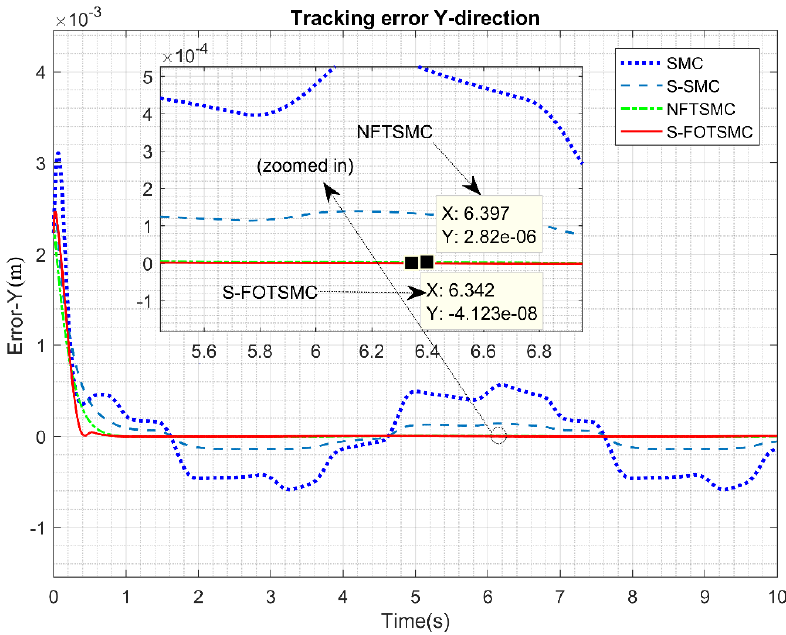
Figure 5. The tracking errors of the end-effector in the Y-direction.